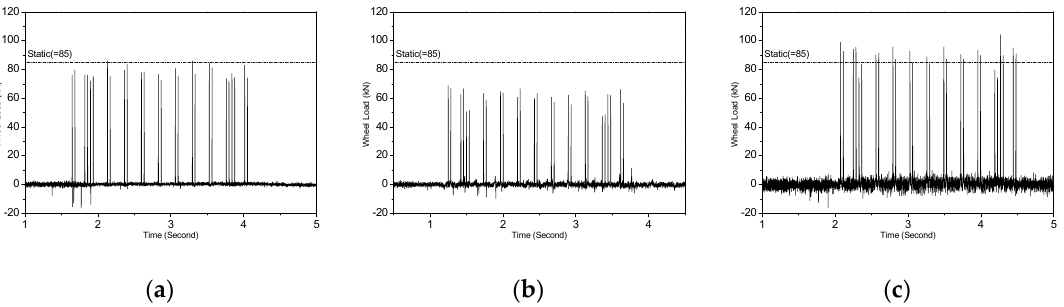
Figure 9. Results of wheel load measured at each point. ( a ) Point 1; ( b ) Point 2; ( c ) Point 3 and 4.